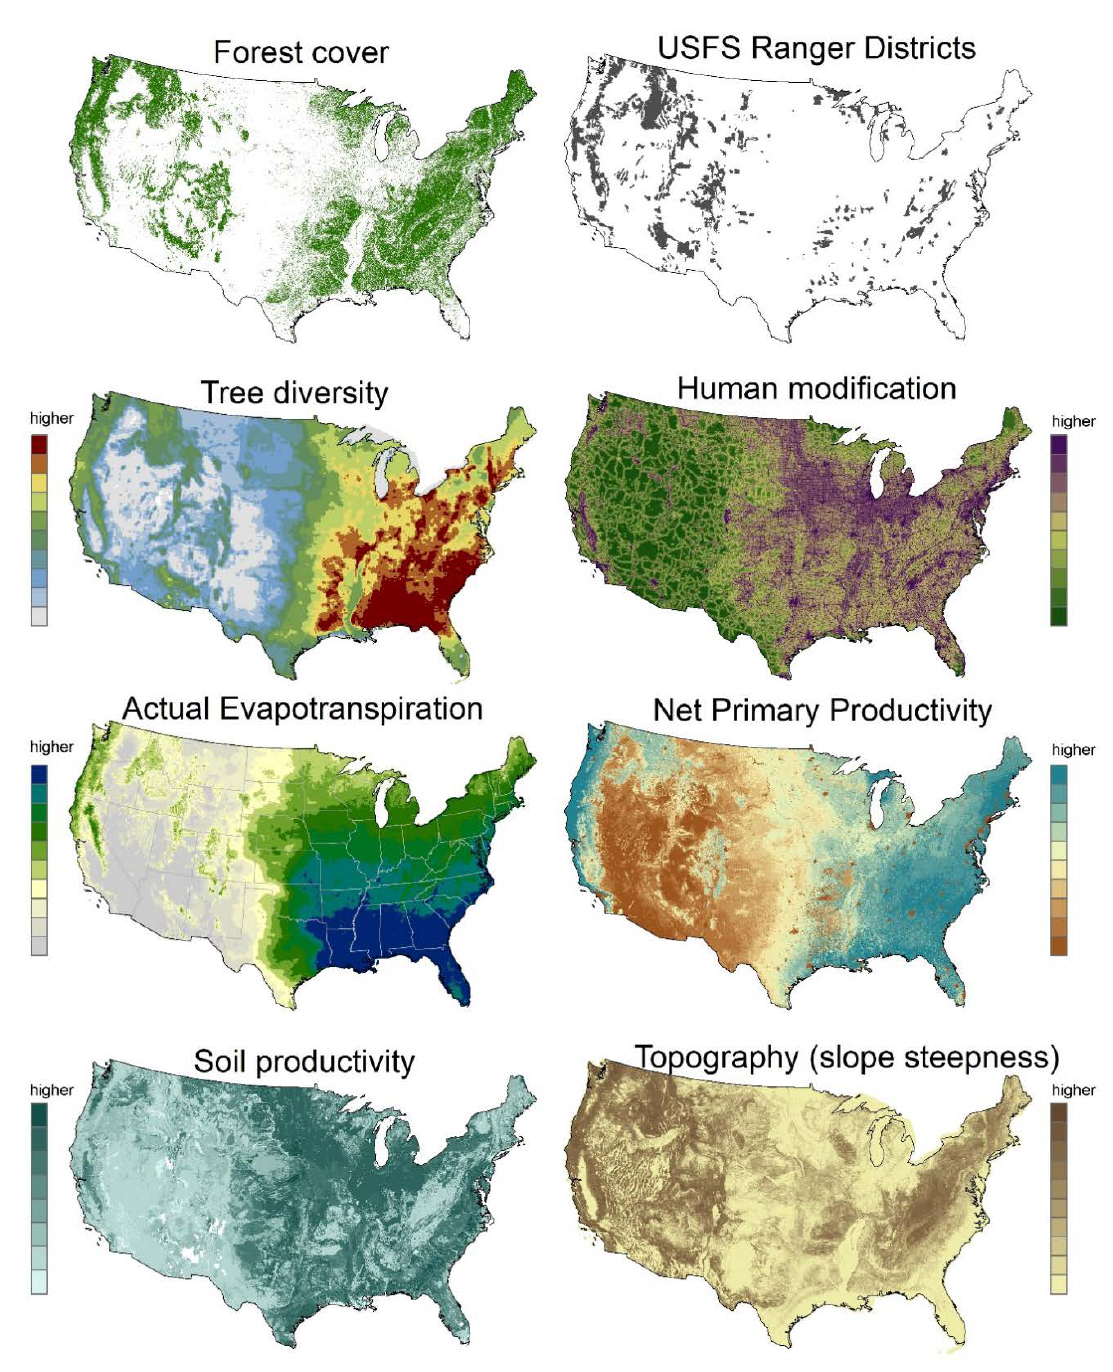
Figure 1. Spatial data used to analyze relationships between tree species richness, the degree of human modification, climate, vegetation productivity, soil productivity, and topography. Forest cover is shown for reference.